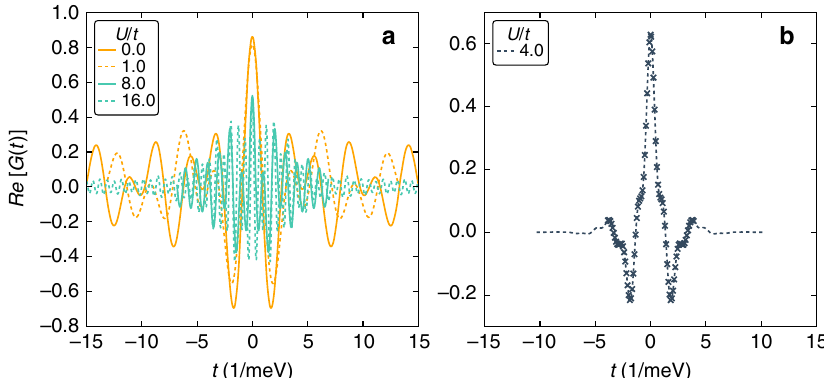
Fig. 6 Real time simulation of G ð t Þ (see Eq. (4)) of the data shown in Fig. 3. Panel a showns U = t ¼ 0, 1, 8 and 16, while panel b displays U = t ¼ 4. In the case of U = t ¼ 4 we extend the reached time scales by using linear prediction. Symbols are calculated data points, the line is the data obtained using